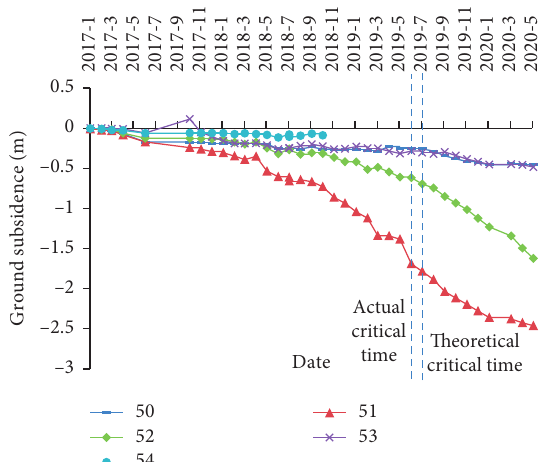
Figure 8: The surface subsidence along strike of 13230 face. [23].